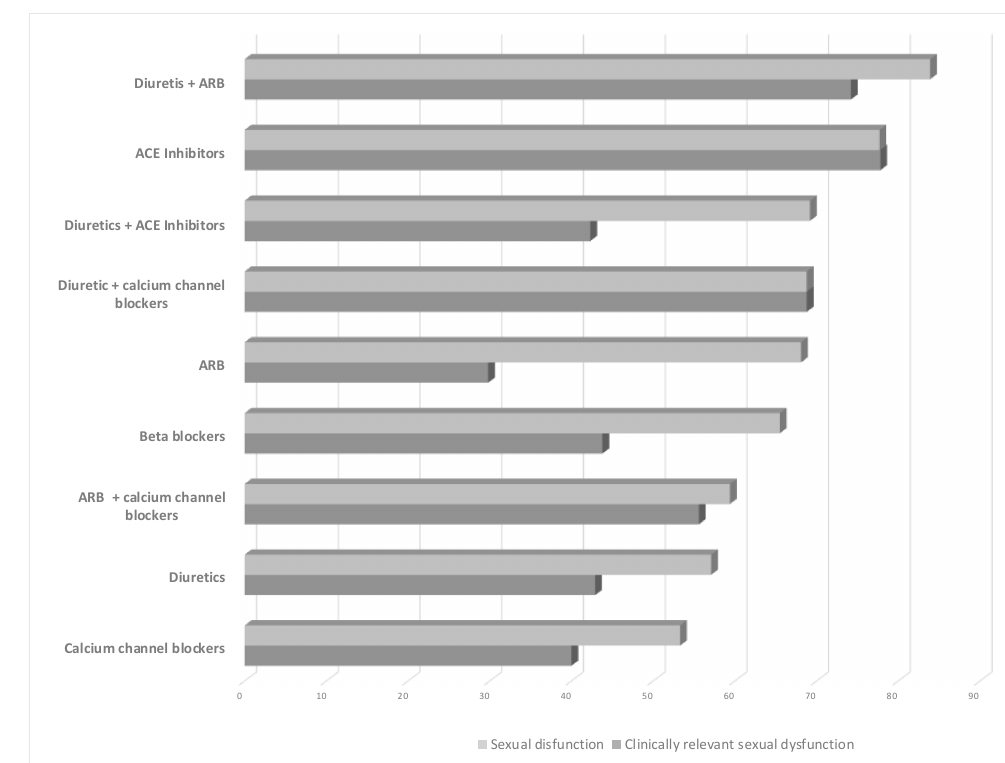
Figure 1. Percentage of patients who reported sexual dysfunction and clinically relevant sexual dysfunction (moderate or severe) for each type of treatment. ACE, angiotensin-converting enzyme; ARB, angiotensin receptor blocker.